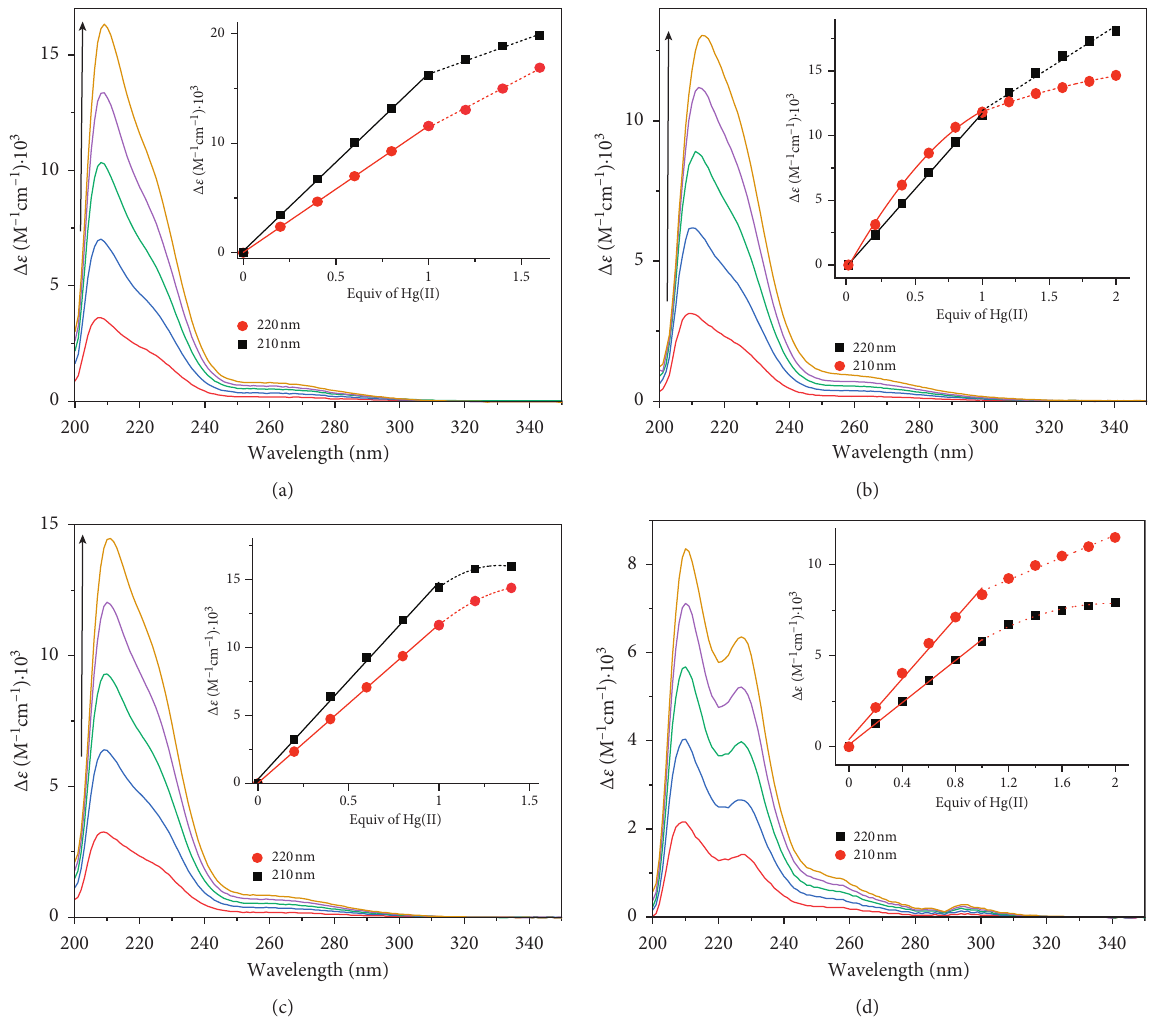
Figure 2: UV absorption difference spectra [ Δ ε � ε (HgPeptide)- ε (Peptide)] correspond to GCGC (a), ECGC (b), HCGC (c), and WCGC (d) from titration with 0.2 to 1.0 mole equiv of HgCl 2 . Inset shows changes in extinction coefficient values at specified wavelengths versus mole equiv of HgCl 2